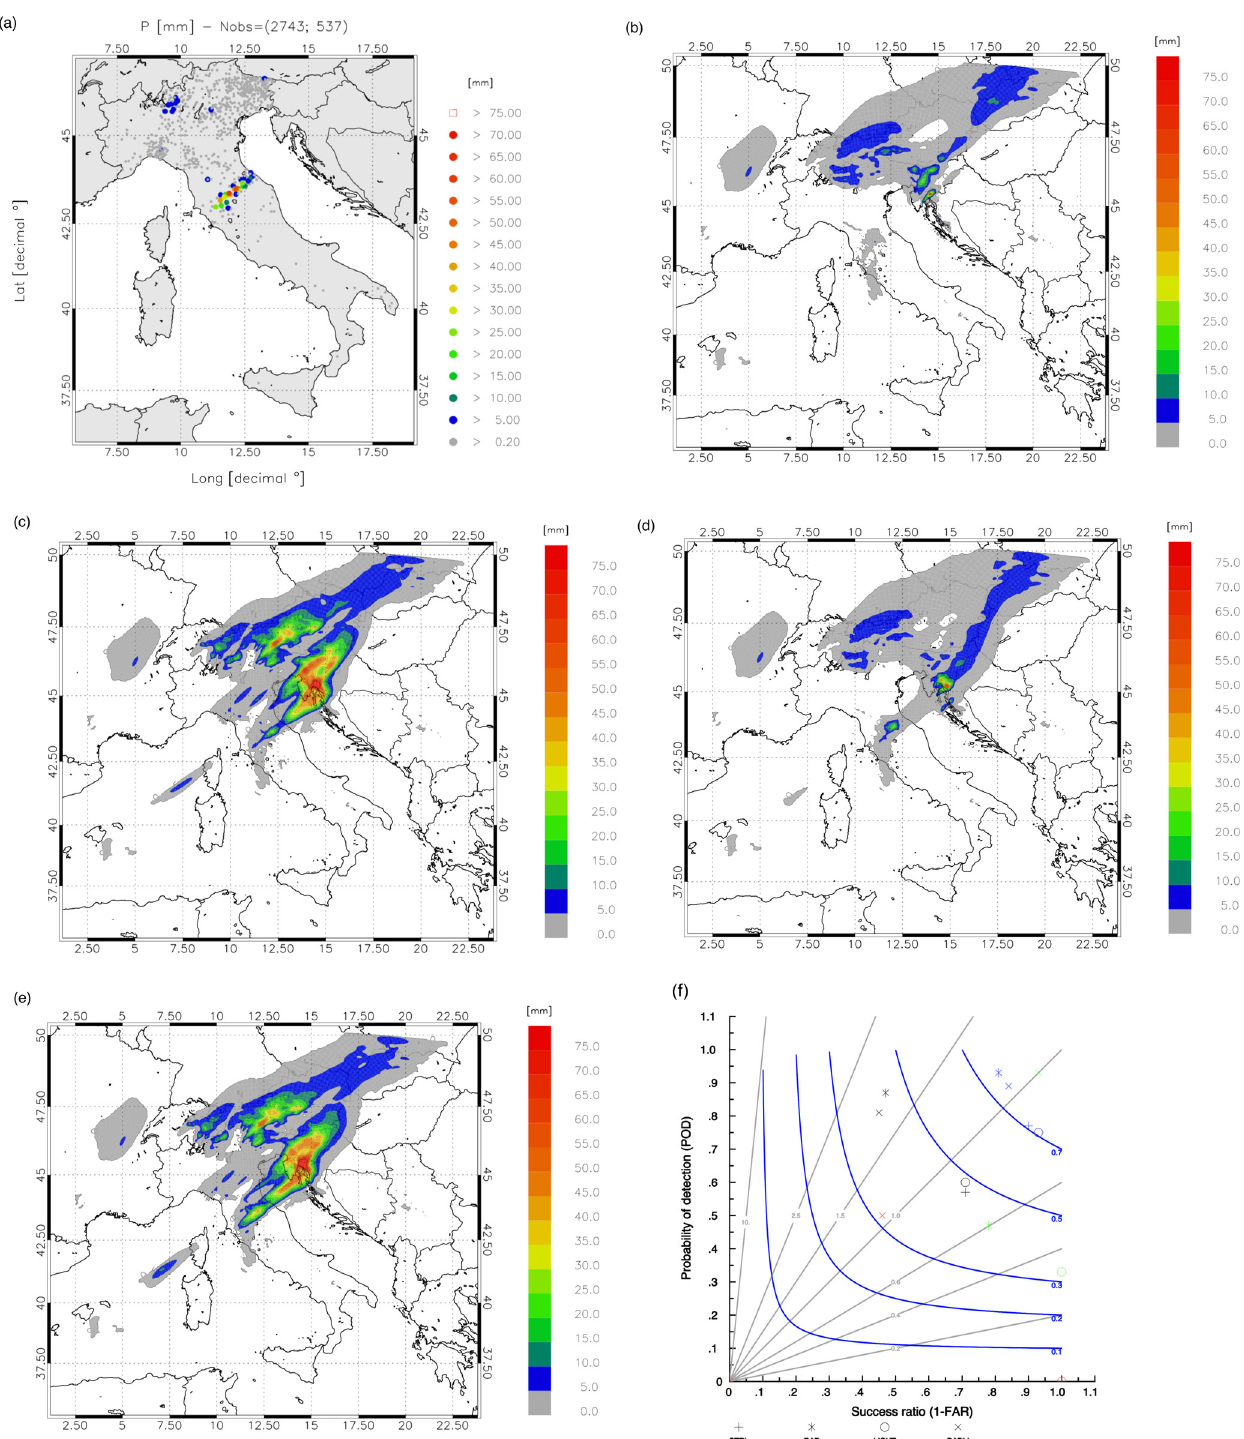
Figure 15. (a) Rainfall reported by rain gauges between 03:00 and 06:00UTC on 16 September 2017. Only rain gauges observing at least 0.2mm every 3h are shown. The first number in the title within brackets represents the available rain gauges, while the second number represents those observing at least 0.2mm every 3h; (b) rainfall VSF of CTRL for the same time interval as in (a) ; (c) as in (b) for RAD forecast; (d) as in (b) for LIGHT forecast; (e) as in (b) for RADLI forecast; (f) performance diagram: black symbols are for the nearest neighbourhood and for the 1mm every 3h threshold; red symbols are for the nearest neighbourhood and for the 30mm every 3h threshold; blue symbols are for the 25km neighbourhood radii and for the 1mm every 3h threshold; green symbols are for the 25km neighbourhood radii and for the 30mm every 3h